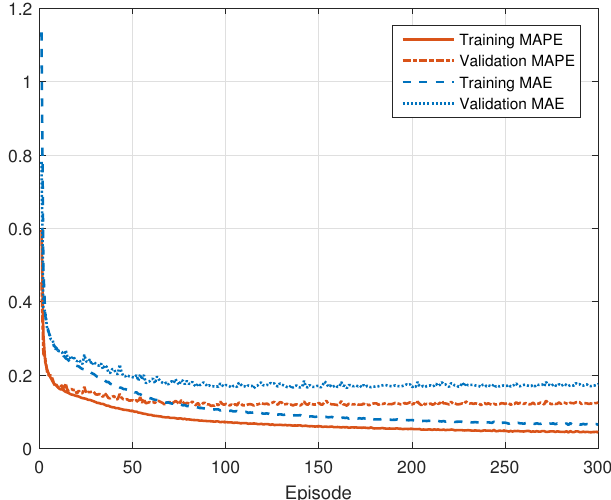
Figure 6. The convergence of the proposed DNN for BER estimation with different loss